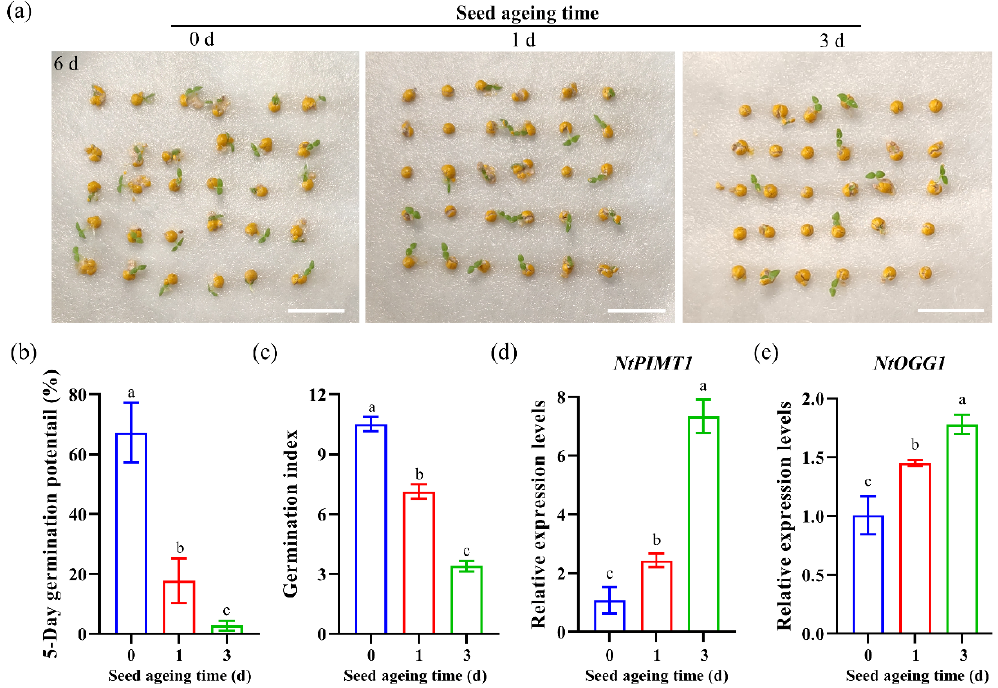
Figure 4. Characteristics of seed vigour and NtPIMT1 and NtOGG1 expression in pelleted seeds of tobacco cultivar ‘Yunyan 87 ′ after artificial ageing treatments. ( a ) Representative images of germination at 6 d under 25 °C conditions in seeds after 0- (CK), 1-, and 3-day ageing treatments. Scale bars = 10 mm. ( b ) Germination potential; ( c ) germination index. Expression pattern of ( d ) NtPIMT1 and ( e ) NtOGG1 in dry seeds. Data are means (±SD), n = 3. Different letters above the column indicate significant differences determined using ANOVA test: p < 0.01.